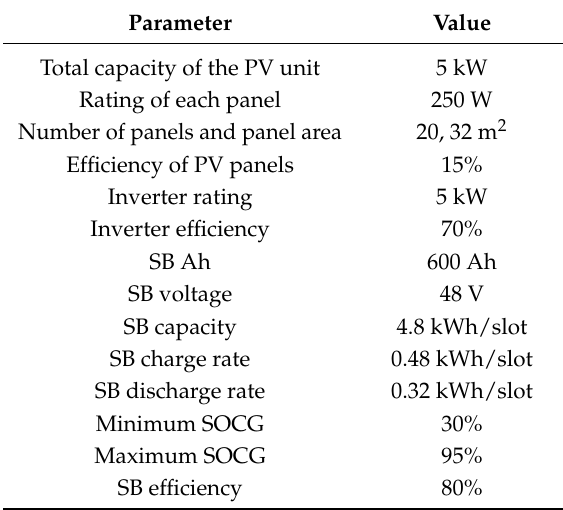
Table 4. PV unit, SB and inverter specifications